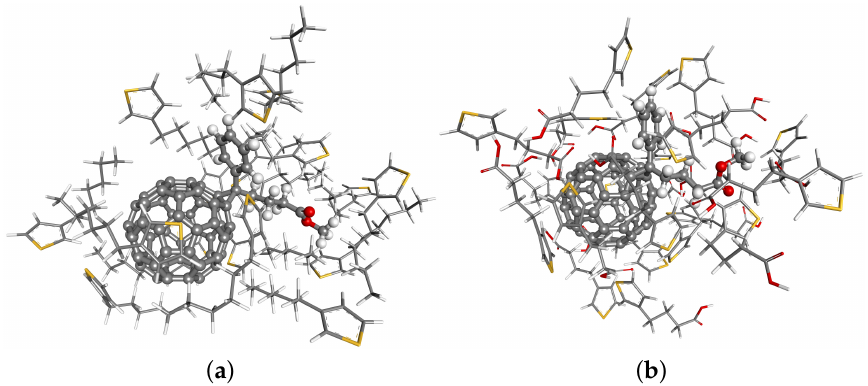
Figure 2. A visualization of DFT-optimized structures of clusters: ( a ) PCBM molecule surrounded by 16 P3HT monomers (520 interaction sites in total); ( b ) PCBM molecule surrounded by 10 P3BT monomers (508 interaction sites in total). Optimization has been performed with the use of the PBC functional [42] with OBS vdW correction [43] and the DND basis